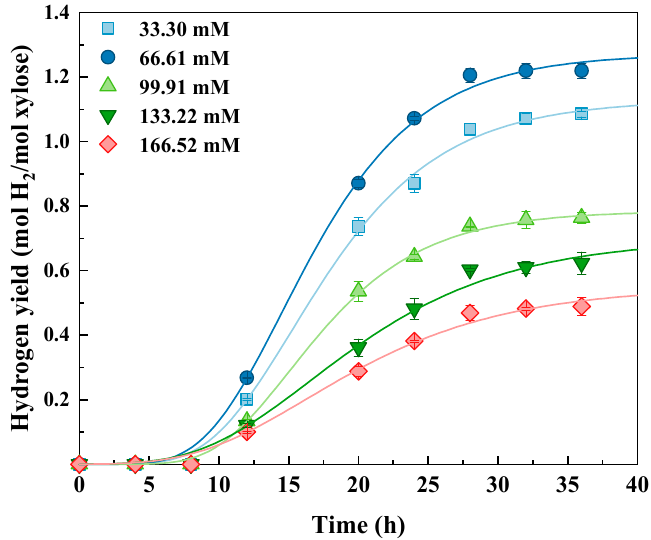
Figure 2. Cumulative bio-hydrogen yield from xylose at varying substrate concentrations with simulation curves based on the modified Gompertz equation.